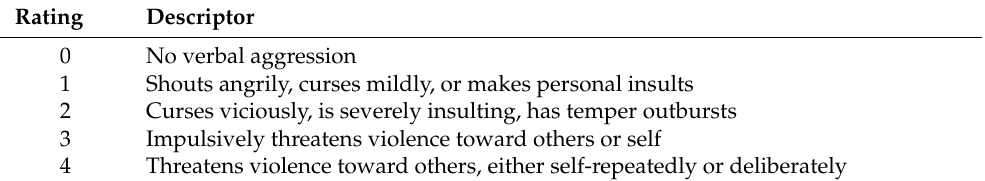
Table 1. Agitation ranking from low to high. From MOAS